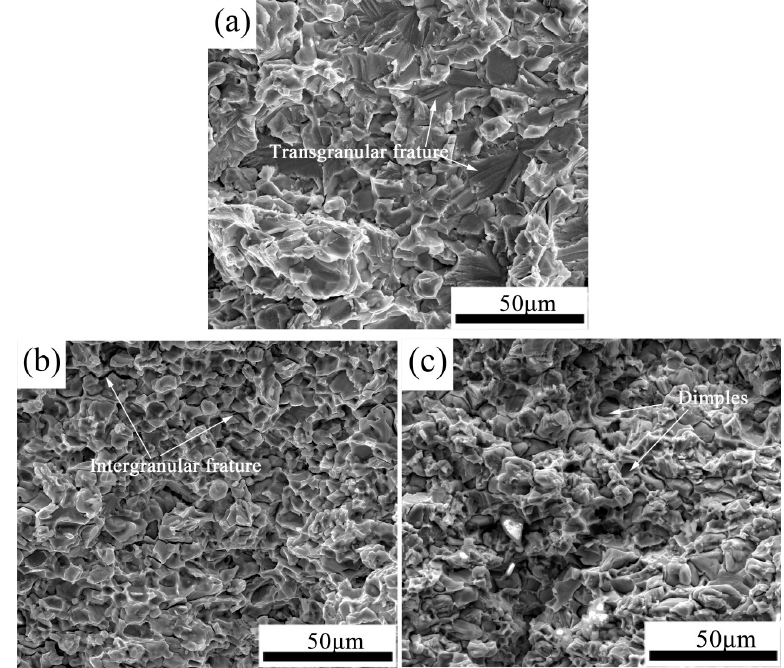
Figure 12. Fracture surfaces of the tensile-test samples at different temperatures: ( a ) At room temperature; ( b ) 700 °C; ( c ) 750 °C.